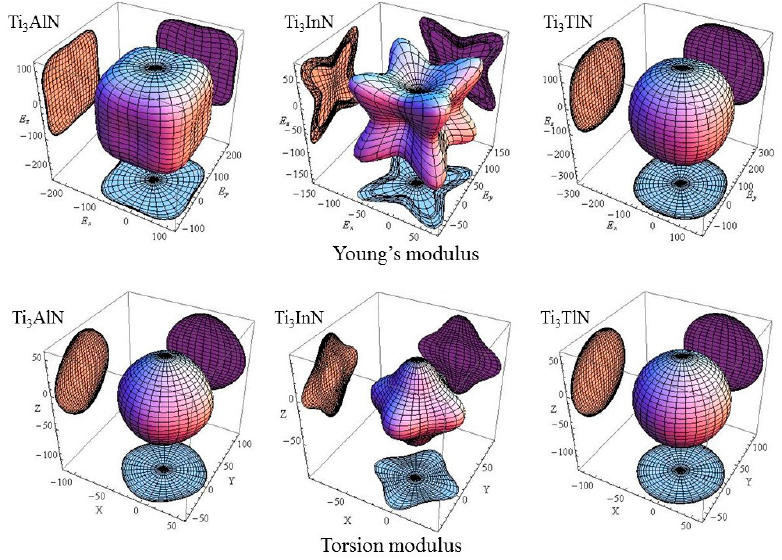
Figure 2. Young’s and torsion modulus of Ti 3 AN in full space. (A = Al, In and Tl).